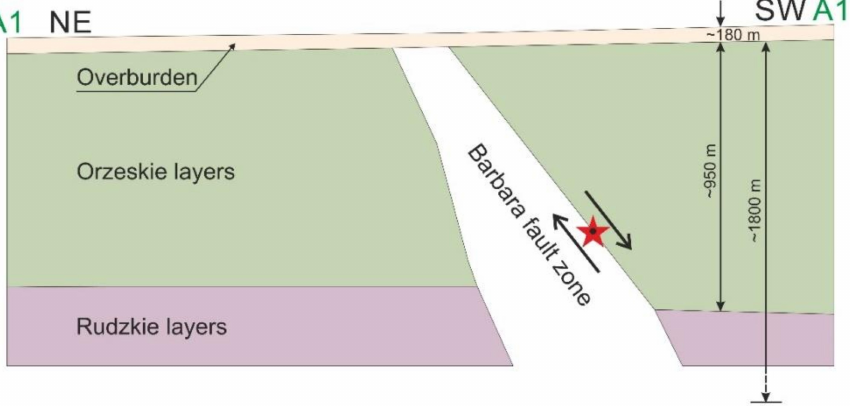
Figure 2. Cross-section through the research area with the Barbara fault zone and the tremor hypocentre that occurred on 8 November 2018. Description in the